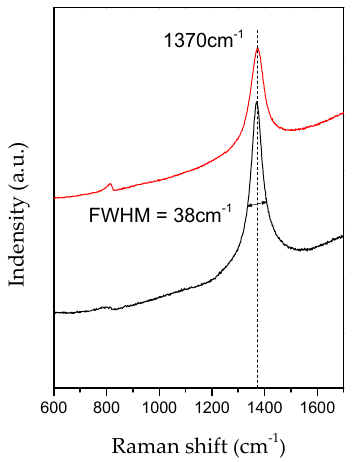
Figure 7. Raman spectra recorded on both TGA residues derived PBN ( red ) and PBN-Li 3 N ( black ). XRD patterns, proposed on Figure 8, also present the signature of hexagonal boron nitride with a main signal at around 26.8° corresponding to the (002) diffraction peak, according to the JCPDS file 009-0012. Moreover, examination of values reported on the Table 2 and corresponding to the main (observed or calculated) [33] XRD parameters clearly shows that the sample prepared with the pure PBN displays a lower crystallization compared to this obtained from PBN-Li 3 N.